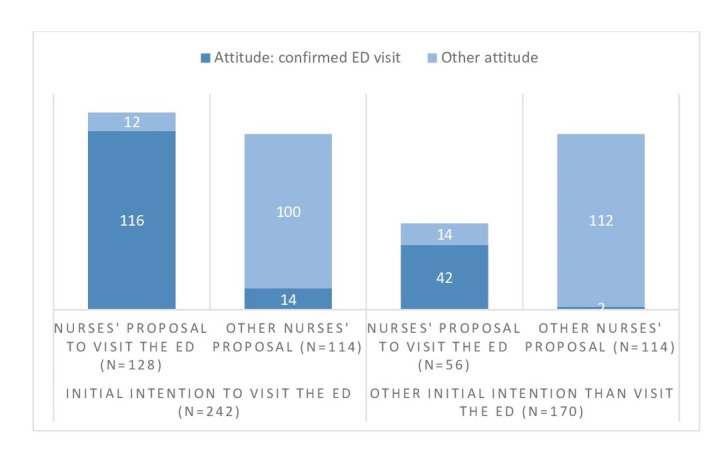
Distribution between proposal made by telephone triage service (TTS) staff and attitude of TTS users according to their primary intention to visit the emergency department (ED) vs. other primary intentions.